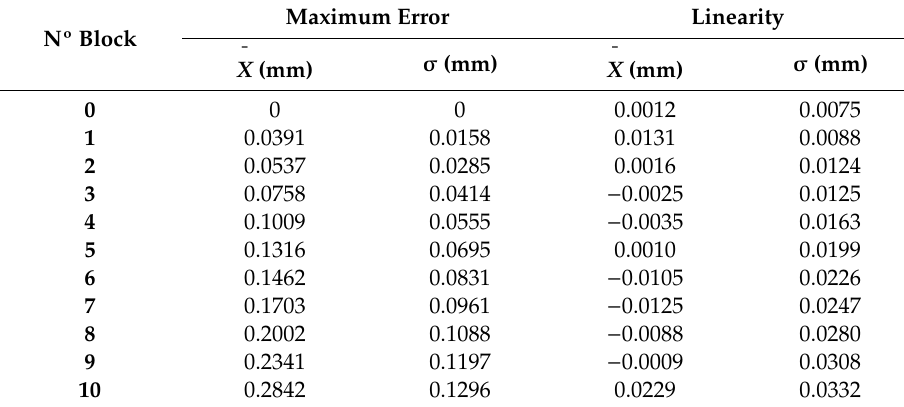
Table 3. Mean value and standard deviation for both maximum error and linearity.